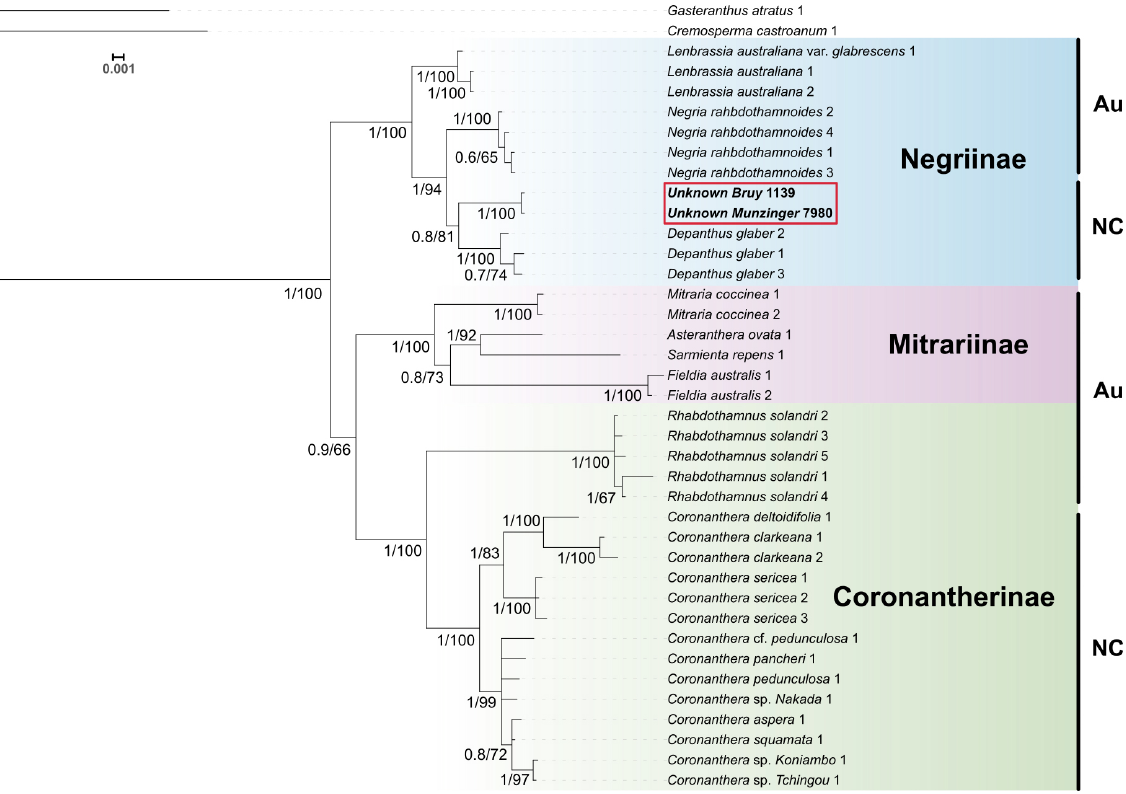
Fig . 1 . 50% Bayesian majority-rule consensus cladogram based on combined markers. Numbers indicating clade support: left of slash = Bayesian posterior probability value; right of slash = maximum likelihood bootstrap value. Au = Australia; NC = New